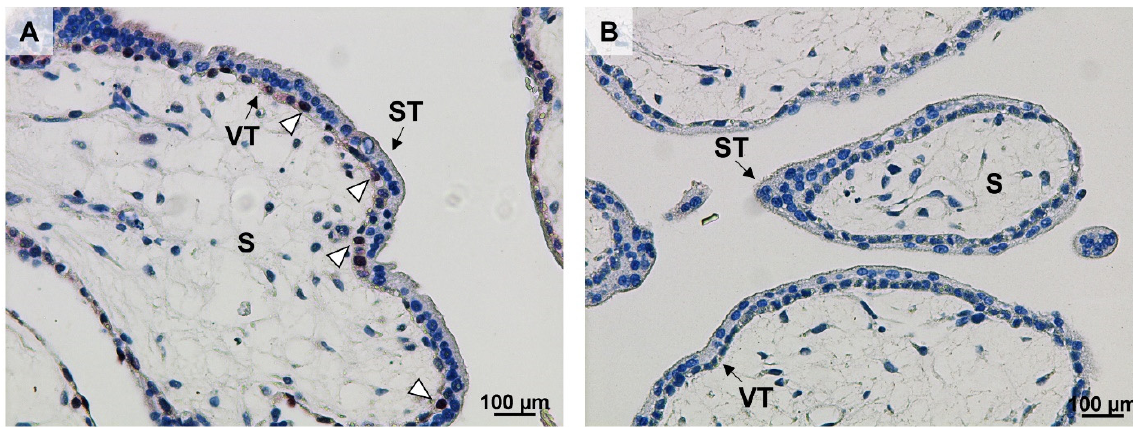
Figure 2. Ki67 localizes to villous cytotrophoblasts (VT) in early pregnancy. Ki67 immunostaining was performed in control first trimester placental tissue ( n = 1, gestational week 7, ( A )). Ki67 was predominantly located in the nuclei of VT (open arrowheads). A negative IgG isotype control is shown in ( B ). Scale bar: 100 µm. VT: villous cytotrophoblasts; ST: syncytiotrophoblast; S: stroma.